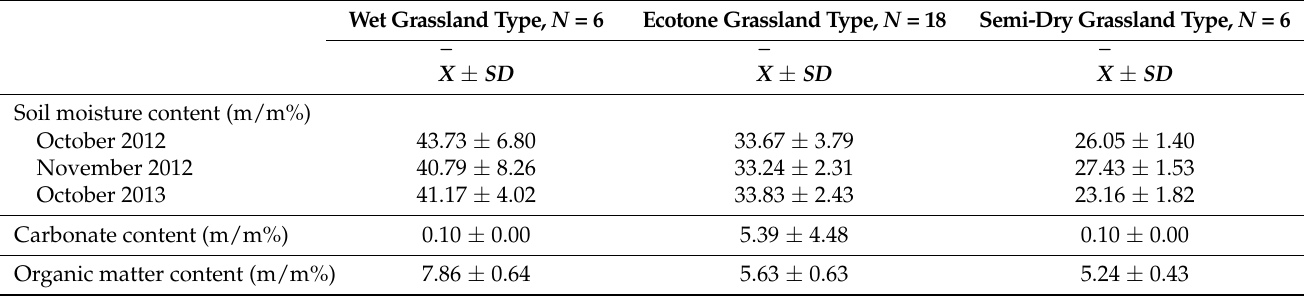
Table A3. Soil properties in the three grassland types with different water